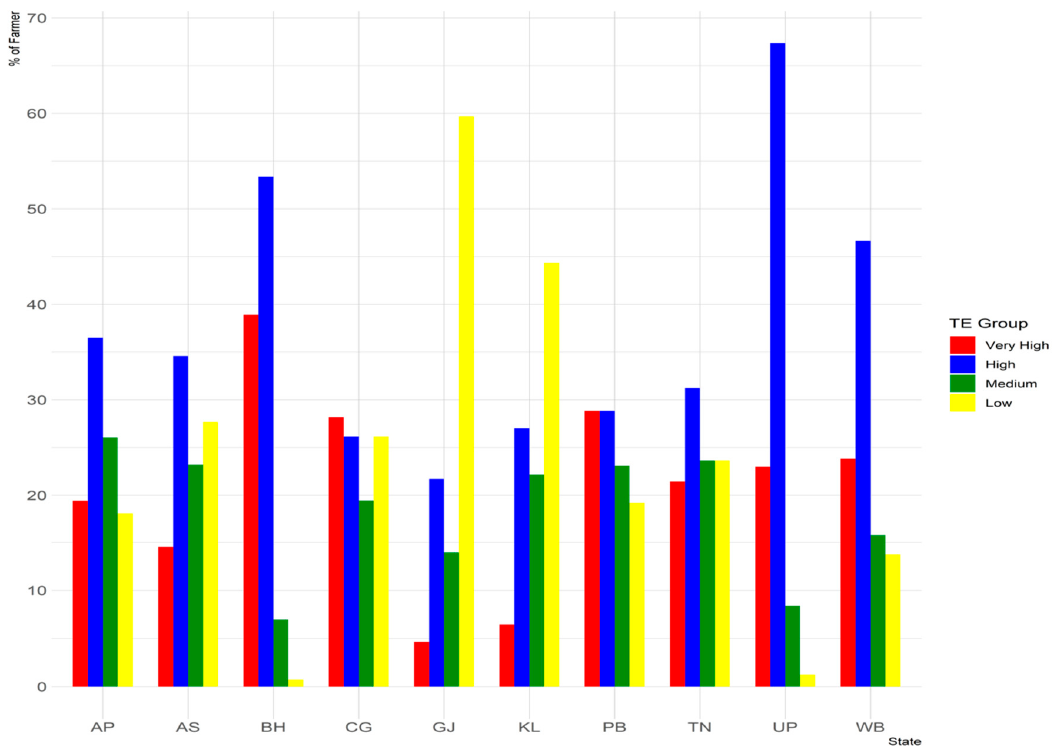
Figure 3. Distribution of technical efficiency in paddy production across various states of India in AY 2016–17.